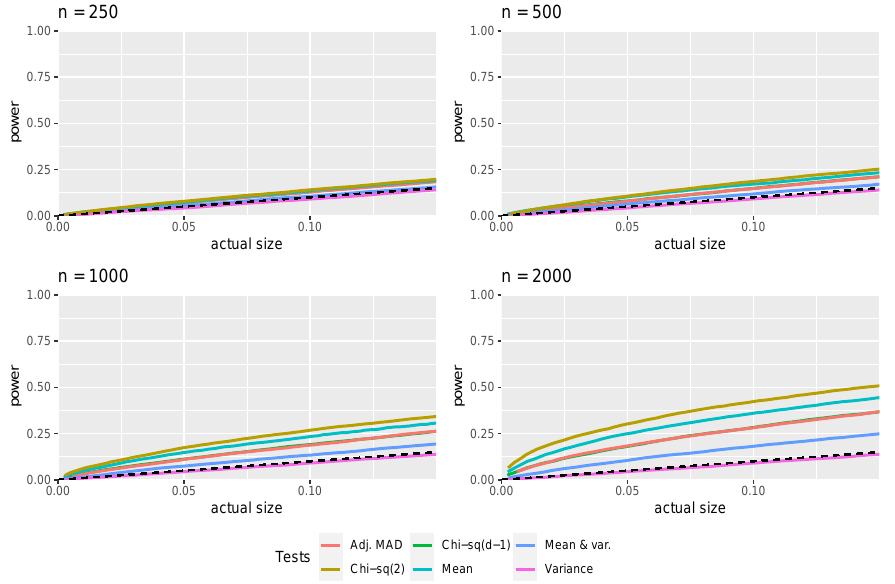
Figure 4. First digit tests: size–power curves of the tests against the normal mixing alternative with λ = 0.9. Tests are as follows: “Adj. MAD”, adjusted MAD (10); “Chi-sq(2)”, χ 2 ( 2 ) test on mean and variance (4); “Chi-sq(d-1)”, χ 2 ( 8 ) test (9); “Mean”, normal test on the mean (1); “Mean & var.”, normal test on mean and variance (3); “Variance”, normal test on variance (2). The dashed line is power = actual size . The number of observations is indicated on top of each panel.